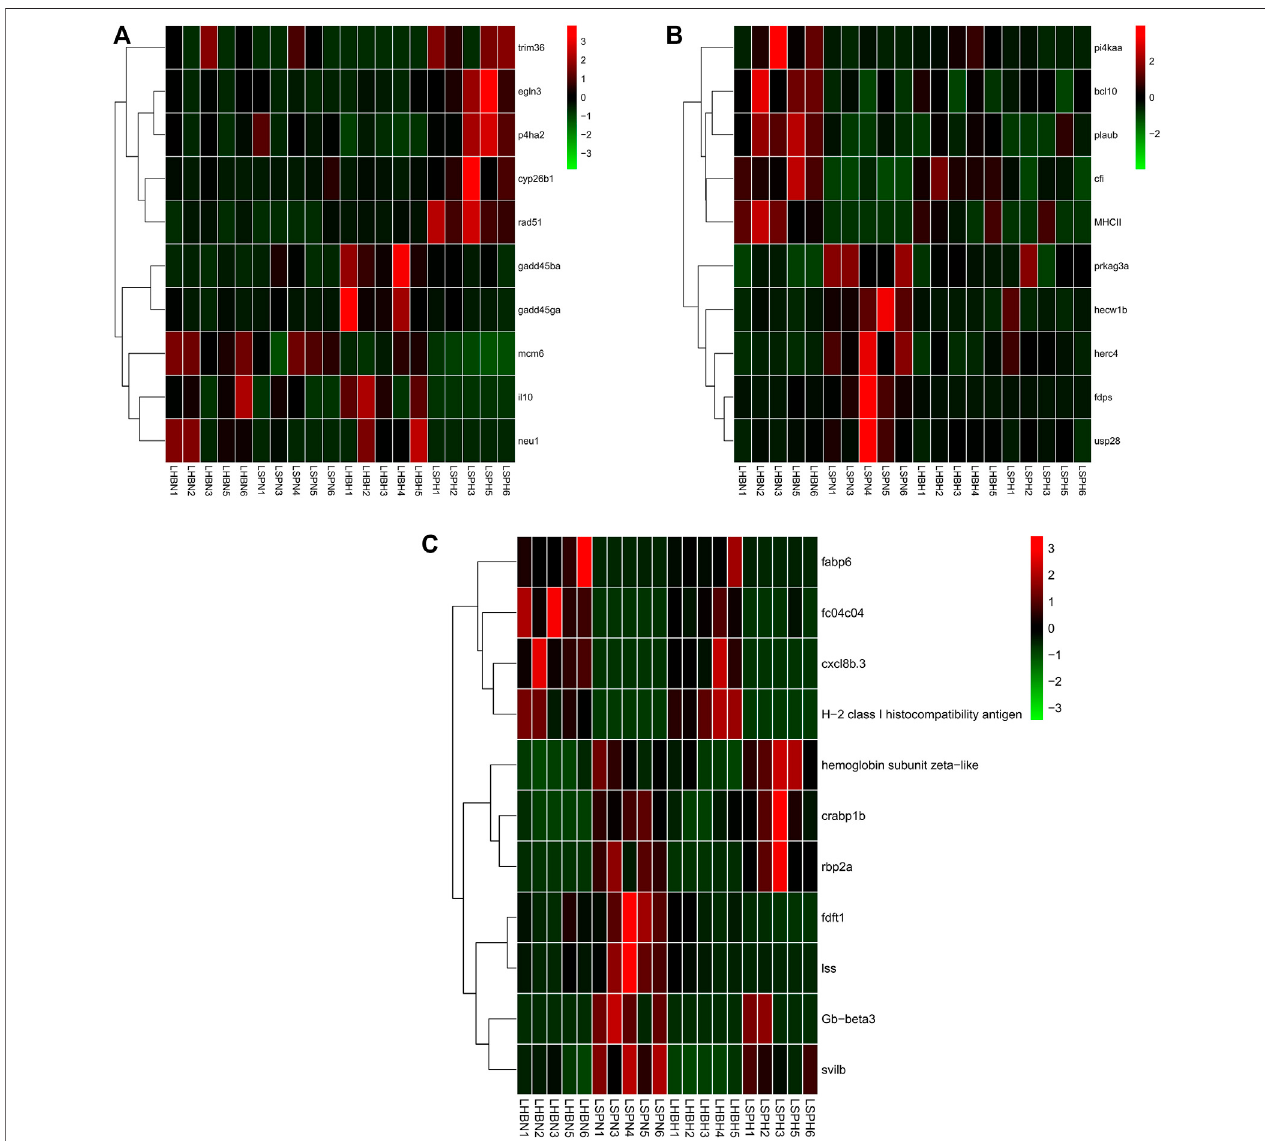
FIGURE 5 | Hierarchical clustering of the three types of genes among three strains of carp liver under hypoxia based on the average correlation of the log2 expression values. (A) HSDEGs. (B) NSDEGs. (C) HNDEGs (LHBN1, LHBN2, LHBN3, LHBN5, LHBN6, LHBH1, LHBH2, LHBH3, LHBH4, LHBH5; LSPN1, LSPN3, LSPN4, LSPN5, LSPN6, LSPH1, LSPH2, LSPH3, LSPH5,